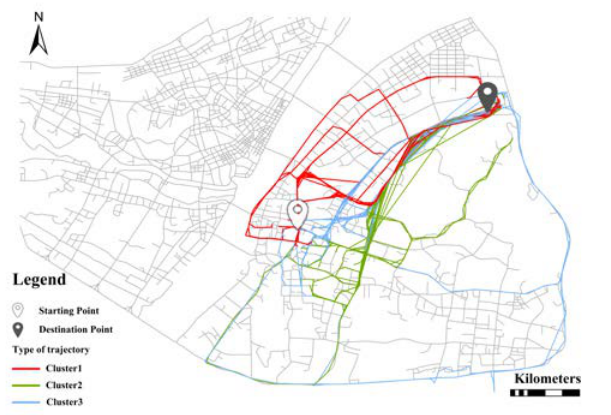
Figure8: The clustering results of the trajectories from Wuchang Railway Station to Wuhan Railway